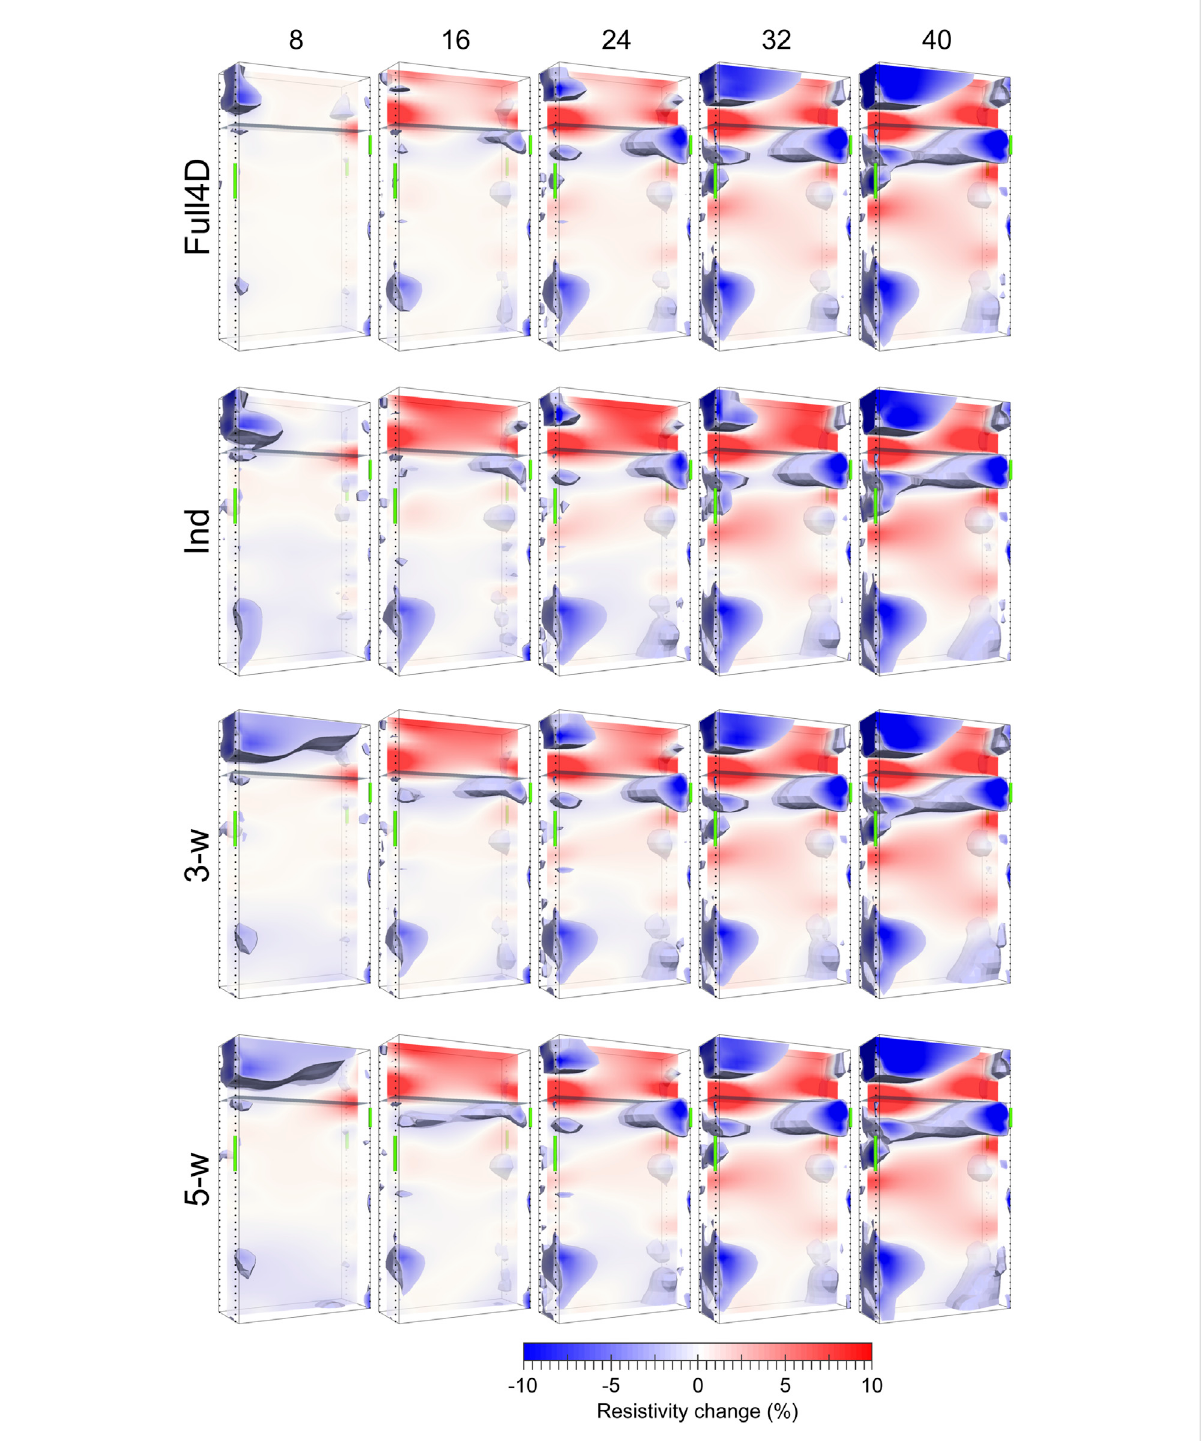
FIGURE 8 Distributionsoffractionalresistivity changeatMSSSforthefullsequence 4D,independent,andwindowedinversionsatthetimestepsindicated at the top of the diagram. Isosurfaces indicate resistivity changes of < − 2%. Green cylinders show regions of historic contamination (data © Sella fi eld